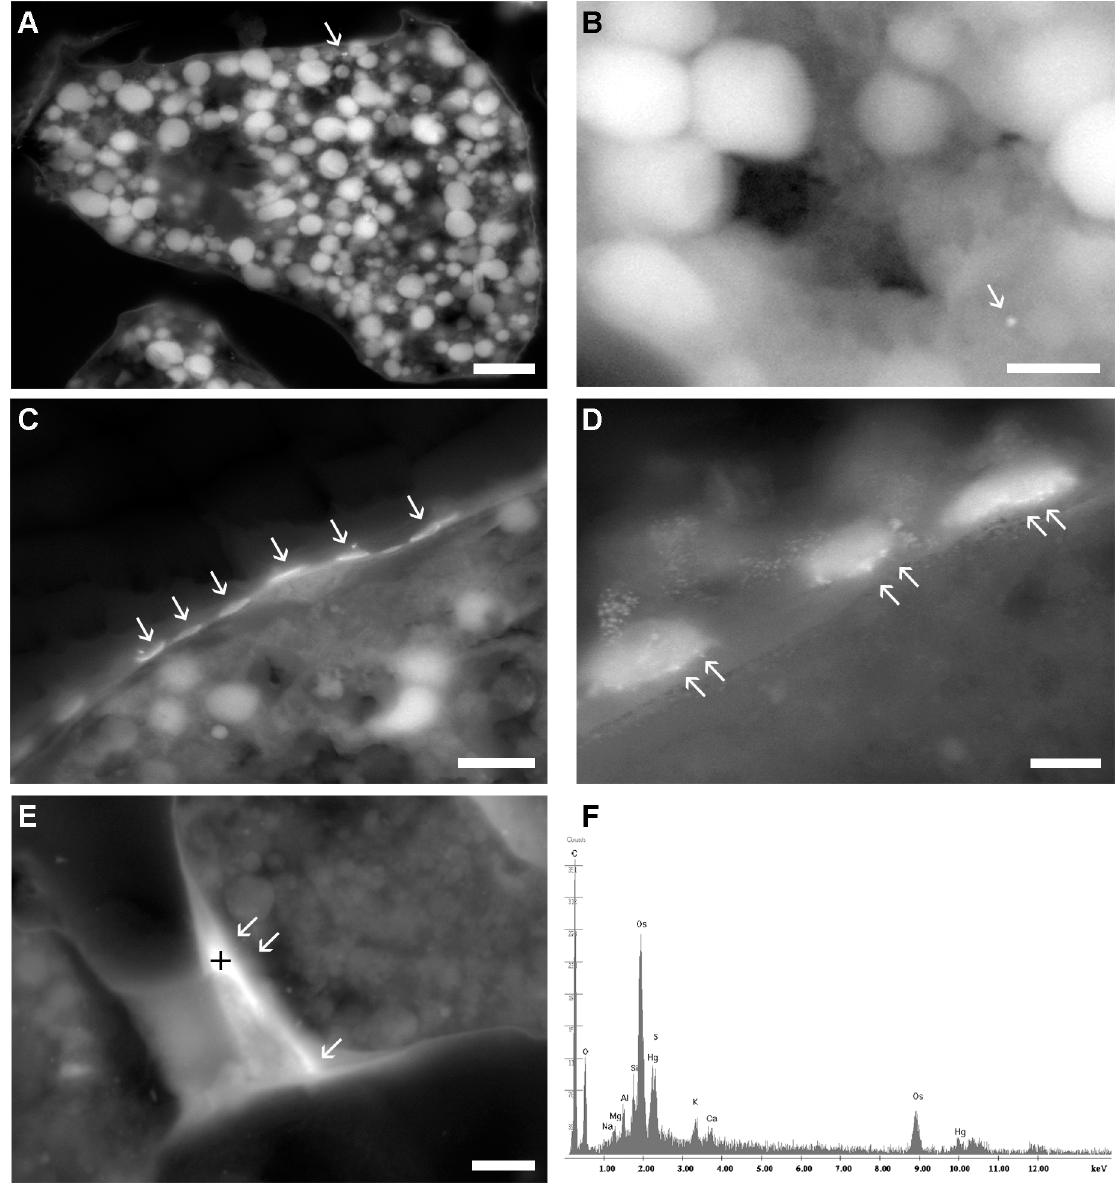
Fig 3. Micrographs showing presence of Hg in A . parkinsoniana specimens (T2-100 ppm). (A) young chamber containing vacuoles; (B) high magnification of a young chamber; (C,D) basal part of pores; (E) foramen/septum. (F) Example EDS spectrum taken with a spot size of 4 on cross (E). Arrows mark the occurrence of Hg. Scale bar: (A) 10 μ m; (B) 1.5 μ m; (C) 2.5 μ m; (D) 0.8 μ m; (E) 5 μ